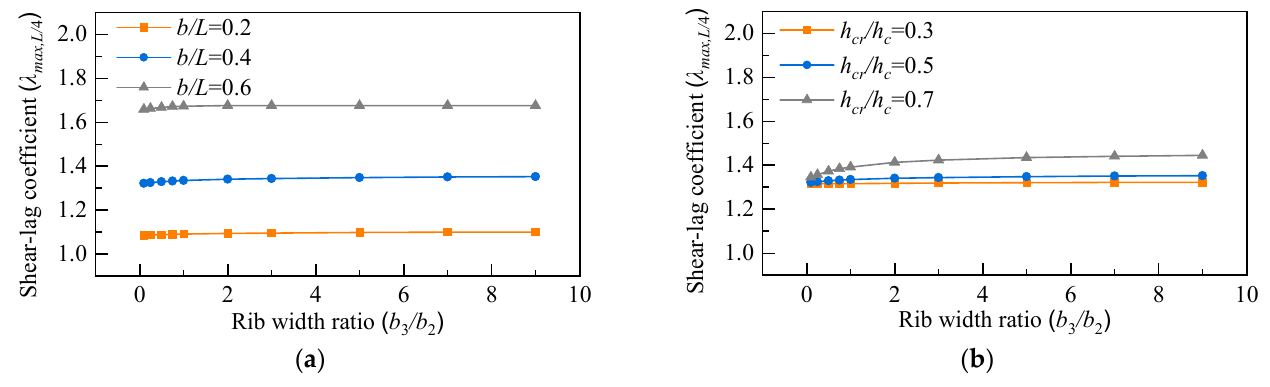
Figure 17. Relation curve of b 3 / b 2 and λ max,L /4 : ( a ) different b/L ( b ) different h cr /h c .